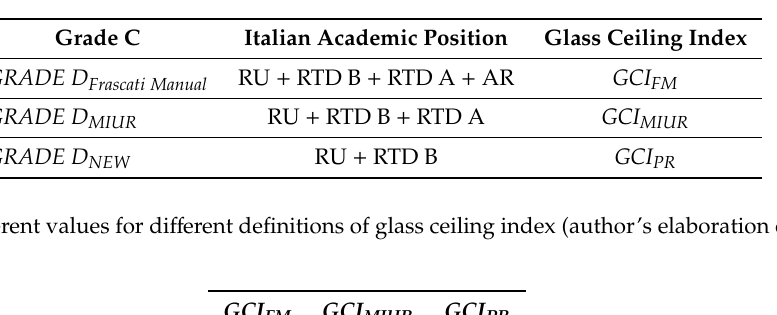
Table 4. Alternative glass ceiling index definitions.